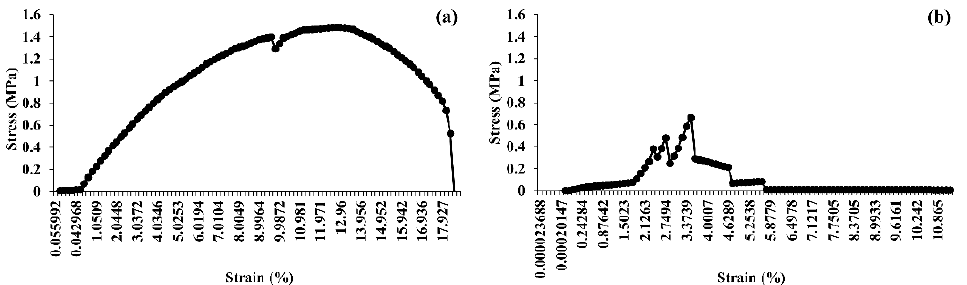
Figure 10. Mechanical property of hydrated ( a ); and dried ( b ) bacterial cellulose pellicles produced by K. maltaceti P285 after incubation at 30 °C for 21 days in HS medium.